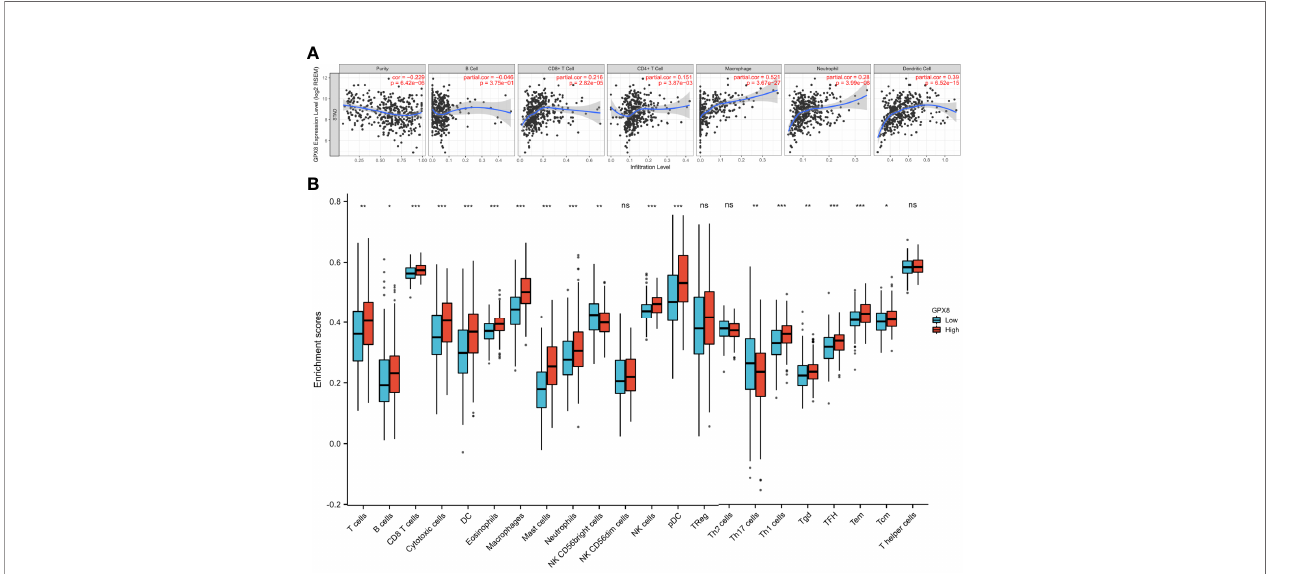
FIGURE 7 | The association of GPX8 and tumor-in fi ltrating lymphocytes in adenocarcinoma carcinoma. (A) GPX8 was positively correlated with in fi ltrating levels of CD4+ T cells, CD8+ T cells, macrophages, neutrophils, and dendritic cells in stomach adenocarcinoma. GPX8 was negatively correlated with purity of immune cells and in fi ltrating levels of B cells. (B) The varied proportions of 22 subtypes of immune cells in the high and low GPX8 expression groups in tumor samples. ns, p ≤ 0.05; *, p < 0.05; **, p < 0.01; ***, p< 0.001.